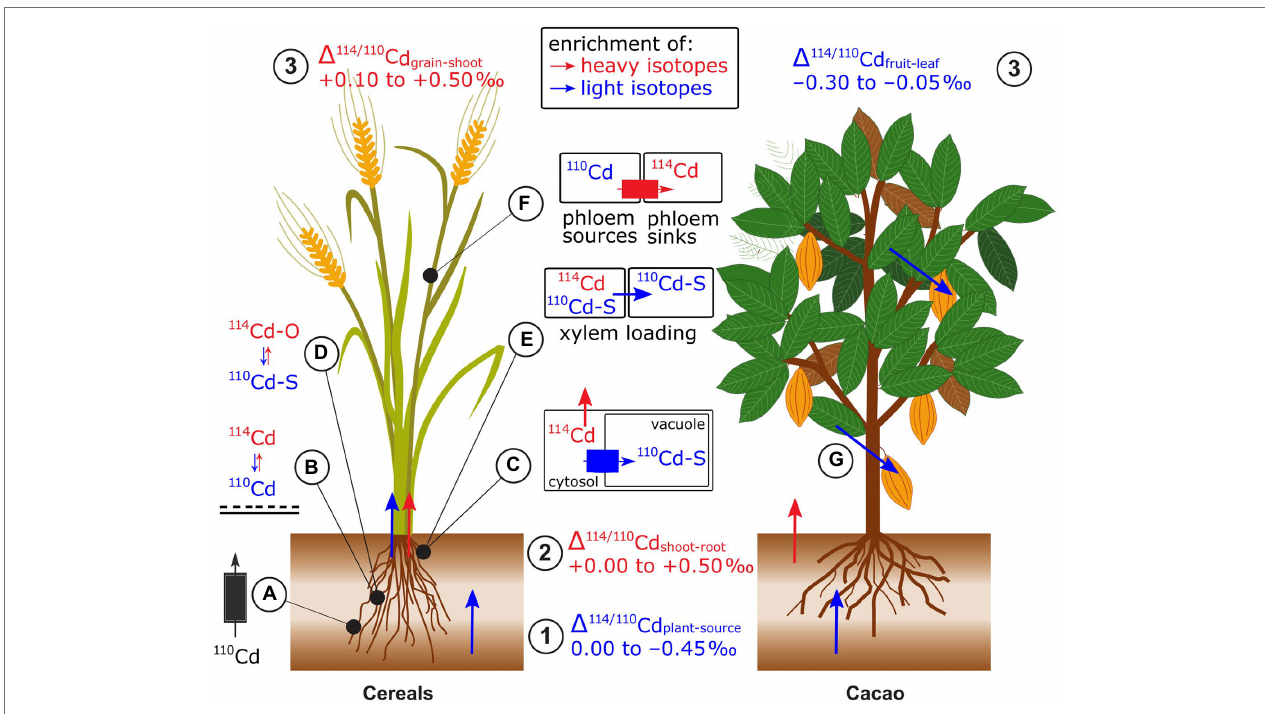
FIGURE 10 | Cadmium isotope fractionation in plants exemplified for cereals and cacao. (1) Root uptake leads to an enrichment of light isotopes in plants. (2) Shoots are mostly enriched in heavy isotopes compared to roots. (3) In cereals, grains are enriched in heavy isotopes compared to the remaining shoot while in cacao, the beans tend to be enriched in light isotopes compared to other shoot parts. (A) Root membrane transport of NRAMP5 induces an enrichment or depletion in light Cd isotopes during uptake. (B) Light isotopes are preferentially sorbed to the negatively charged surfaces in the root apoplast. (C) Light Cd isotopes are sequestrated in root vacuoles via tonoplast proteins. (D) Chelation of Cd by thiols (Cd-S) contributes to the sequestration of light Cd in roots. (E) The non-membrane bound protein CAL1 that preferentially binds light Cd with thiols in the xylem parenchyma cells and transports light Cd into the xylem. (F) Xylem to phloem transfer in the nodes favors heavy Cd isotopes through transport by OsHMA2 and LCT. (G) In cacao, given that beans are enriched in light isotopes compared to leaves, the processes transporting and loading Cd into beans may differ from